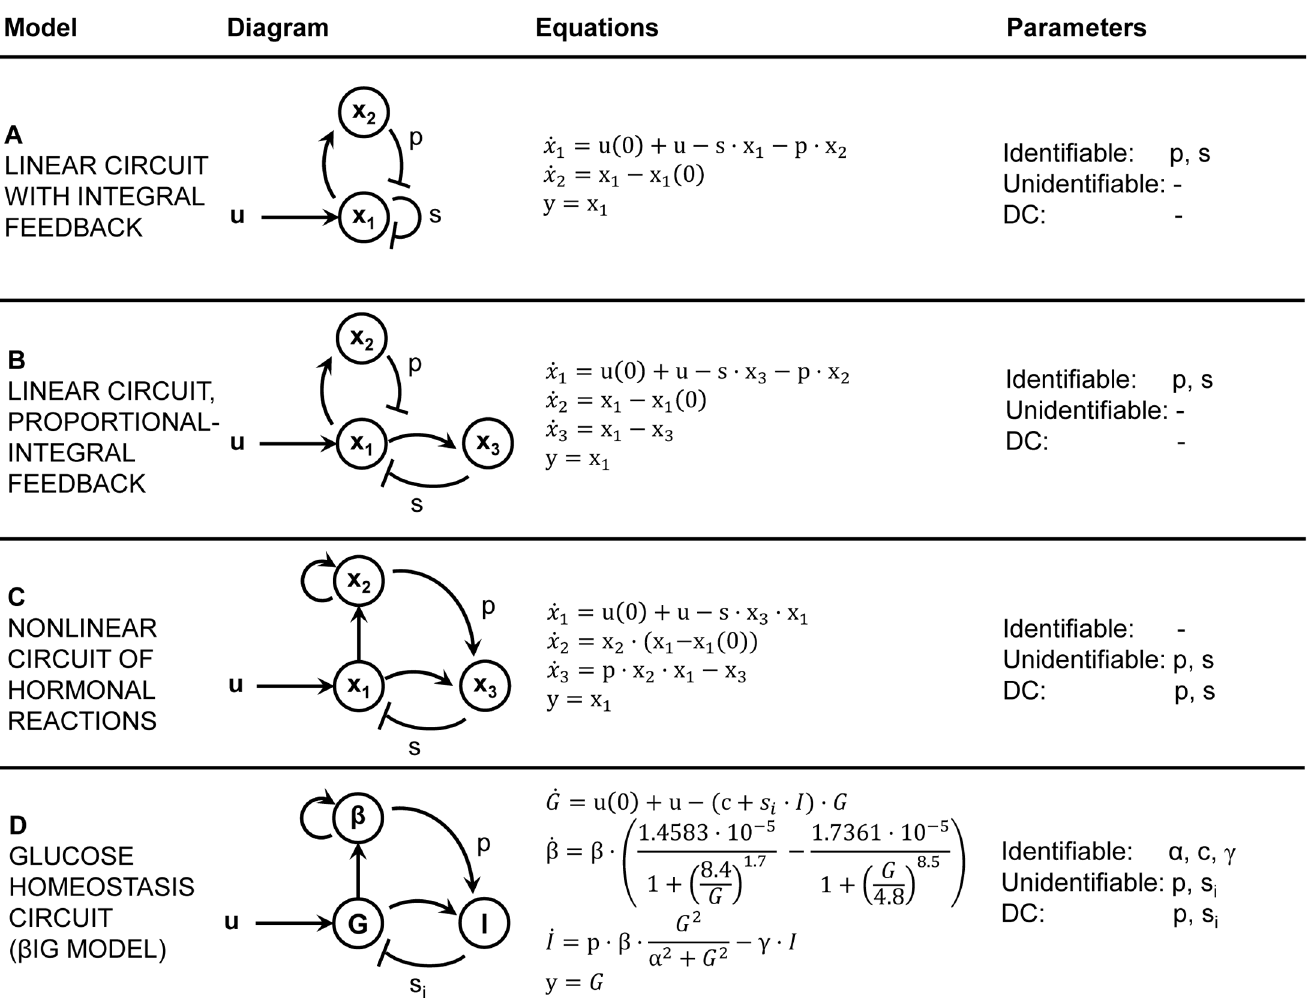
Fig 1. Physiological systemsused as case studies. The four circuits shown here represent deterministic dynamicmodels describedby ordinary differential equations(ODEs) [6]. (A) Linear circuit, integralfeedback. (B) Linearcircuit, proportional-integralfeedback. (C) Nonlinearcircuit of hormonal reactions. (D) Glucose homeostasis circuit, also known as β IG model. Parameters p and s (or s i ) represent gain constants of the feedbackloops present in the circuits.